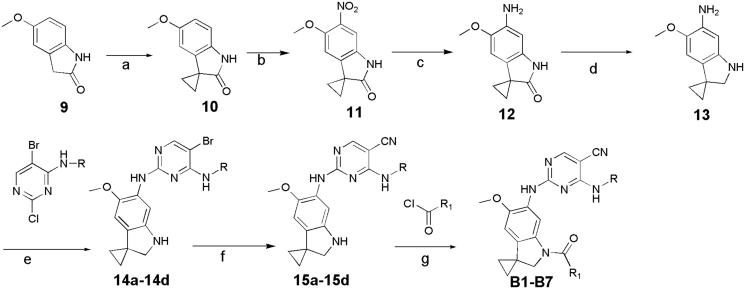
Synthesis of B1-B7, Reagents and conditions:(a) (i) iPr2NH, nBuLi, THF, –60 °C, (ii) BrCH2CH2Br, 60 °C; (b) HNO3, Ac2O, DCM, rt; (c) Fe, NH4Cl, MeOH, H2O; (d) LiAlH4, THF, 70 °C; (e) pTSA, Dioxane,100 °C, 2 h; (f) Zn(CN)2, DMF, H2O, 120 °C(MW)/90 min; (g) TEA, DCM, 0 °C, 2 h.